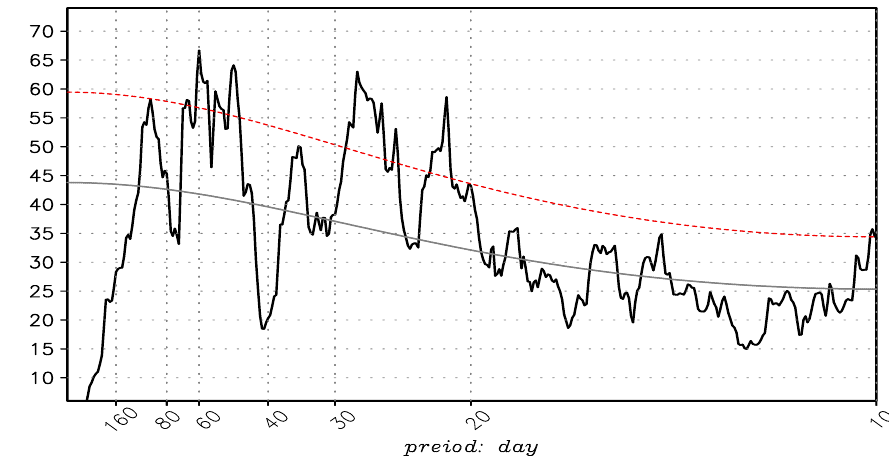
Figure 2. Power spectrum analysis for the 10–80-day MLRYB (The middle and lower reaches of the Yangtze River basin) rainfall index, with the Markov red noise spectrum (grey line), and a priori 95% confidence bound (red dashed line).